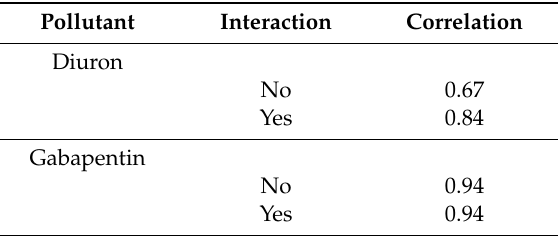
Table 9. Gaussian model correlation study.